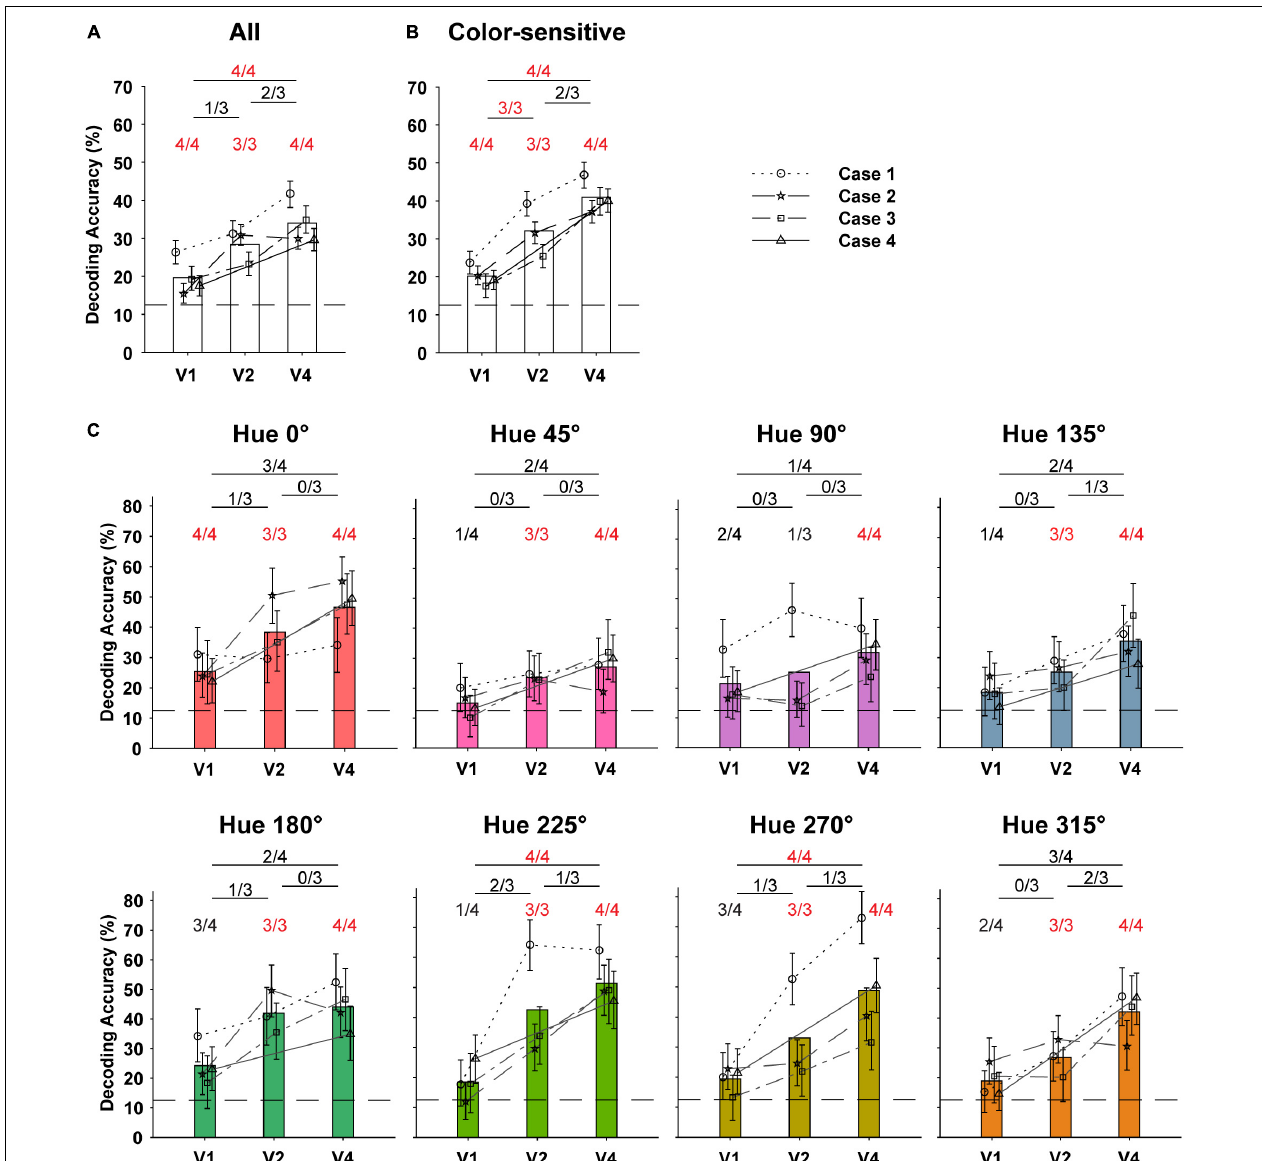
FIGURE 7 | Decoding of hues in DKL color space using optical signals in the V1, V2, and V4. (A) Decoding accuracies of classifiers trained to identify the eight hues using patterns of optical signals obtained from different visual cortices ( n = 4 for V1 and V4, n = 3 for V2) of four monkeys. For training the classifier, pixels of the response maps, each of which was binned to be 80.4 µ m × 80.4 µ m in size, were used as input features (see section “Materials and Methods”). In order to make comparisons between cortices, the number of input features (binned pixels) was kept the same across areas. We plotted the means of decoding accuracies obtained from 1,000 bootstrap procedures with error bars (95% confidence intervals). The bars show the average of the mean decoding accuracy for multiple monkeys, for visualization purposes. The number of cases in which the decoding accuracy was significantly higher than the chance level (12.5%) among the examined cases is shown above the bar (one-tailed bootstrap test, P < 0.05). The number of cortex pairs in which decoding accuracy was significantly different among the examined pairs was shown above the horizontal line at the top (two-sided bootstrap test, P < 0.05). If all cases or pairs were significant, the number is shown in red. (B) Decoding accuracies of hue classifiers trained using only signals in the color-sensitive regions identified by two-way ANOVA (see Figure 1H ). (C) Decoding accuracies for each hue in the hue decoding using the signals in the color-sensitive